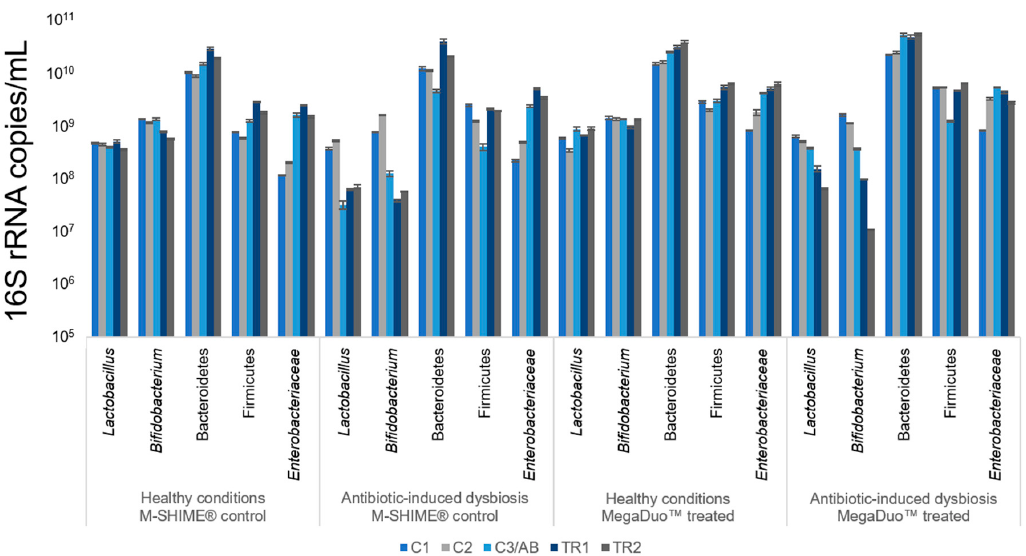
Figure 2. Luminal microbial community composition as assessed by qPCR. All data are shown as 16S rRNA copies / mL in the luminal phase of the proximal colon. All samples were analyzed in triplicate. Data are shown as mean ± standard deviation. C1 = control Week 1; C2 = control Week 2; C3/AB = control Week 3 (healthy condition, pre-treatment) / antibiotic (antibiotic-induced dysbiosis condition, pre-treatment); TR1 = treatment Week 1; TR2 = treatment Week 2; M-SHIME ® = mucosal simulator of the human intestinal microbial ecosystem.